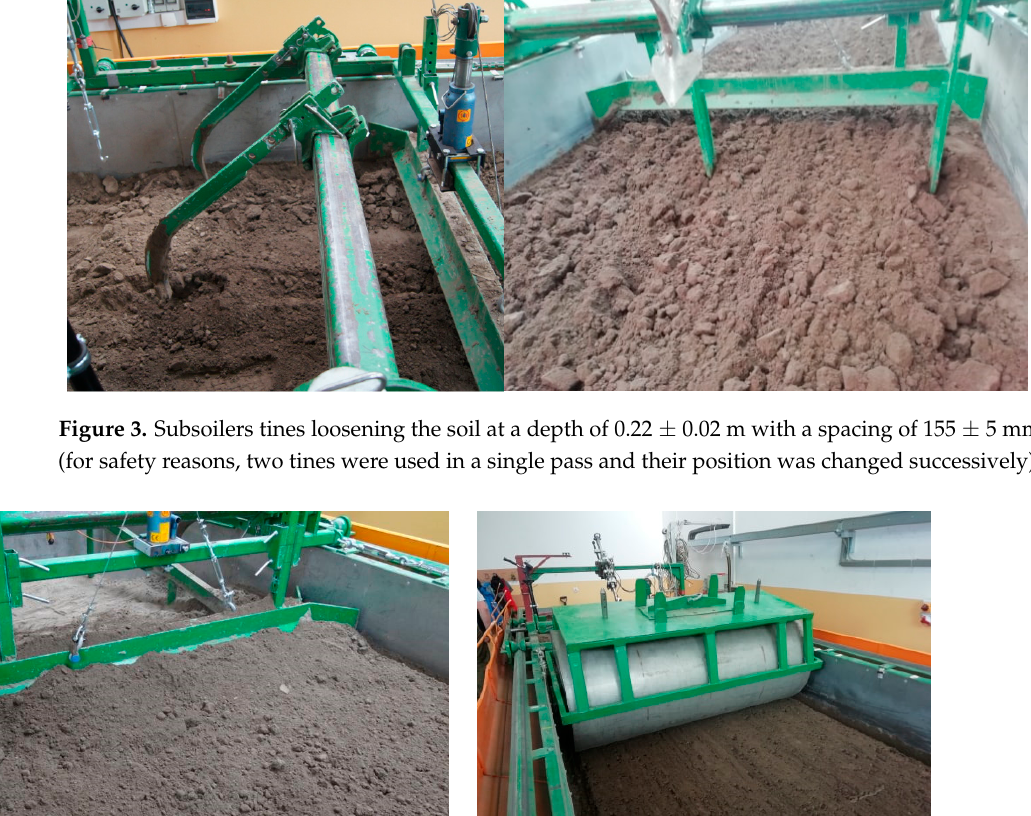
Table 2. Mass of stones used in tests. Rows